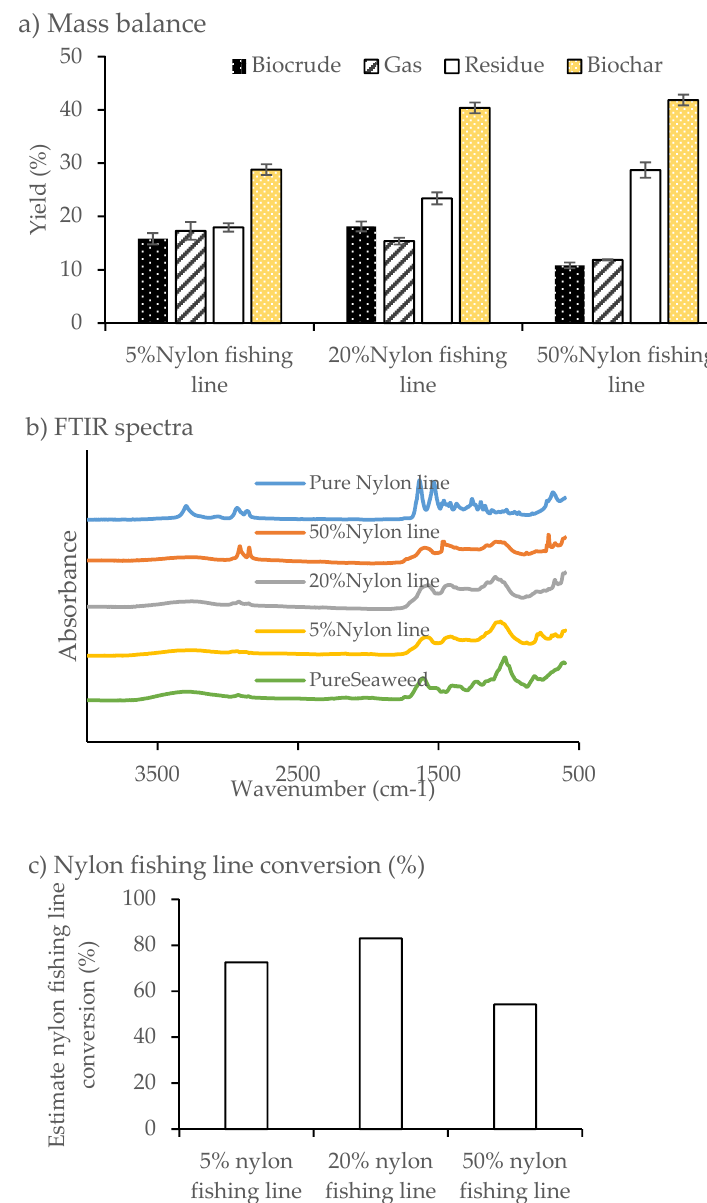
Figure 8. ( a ) Mass balance of coliquefaction of fishing line and F. serratus . ( b ) FTIR spectra of pure nylon fishing line and the solid phase from hydrothermal coliquefaction of F. serratus with 5%, 20% and 50% nylon fishing line blends. ( c ) Estimated nylon fishing line conversion in the coliquefaction of F. serratus as calculated by FTIR (see Supplementary Materials for the full method).